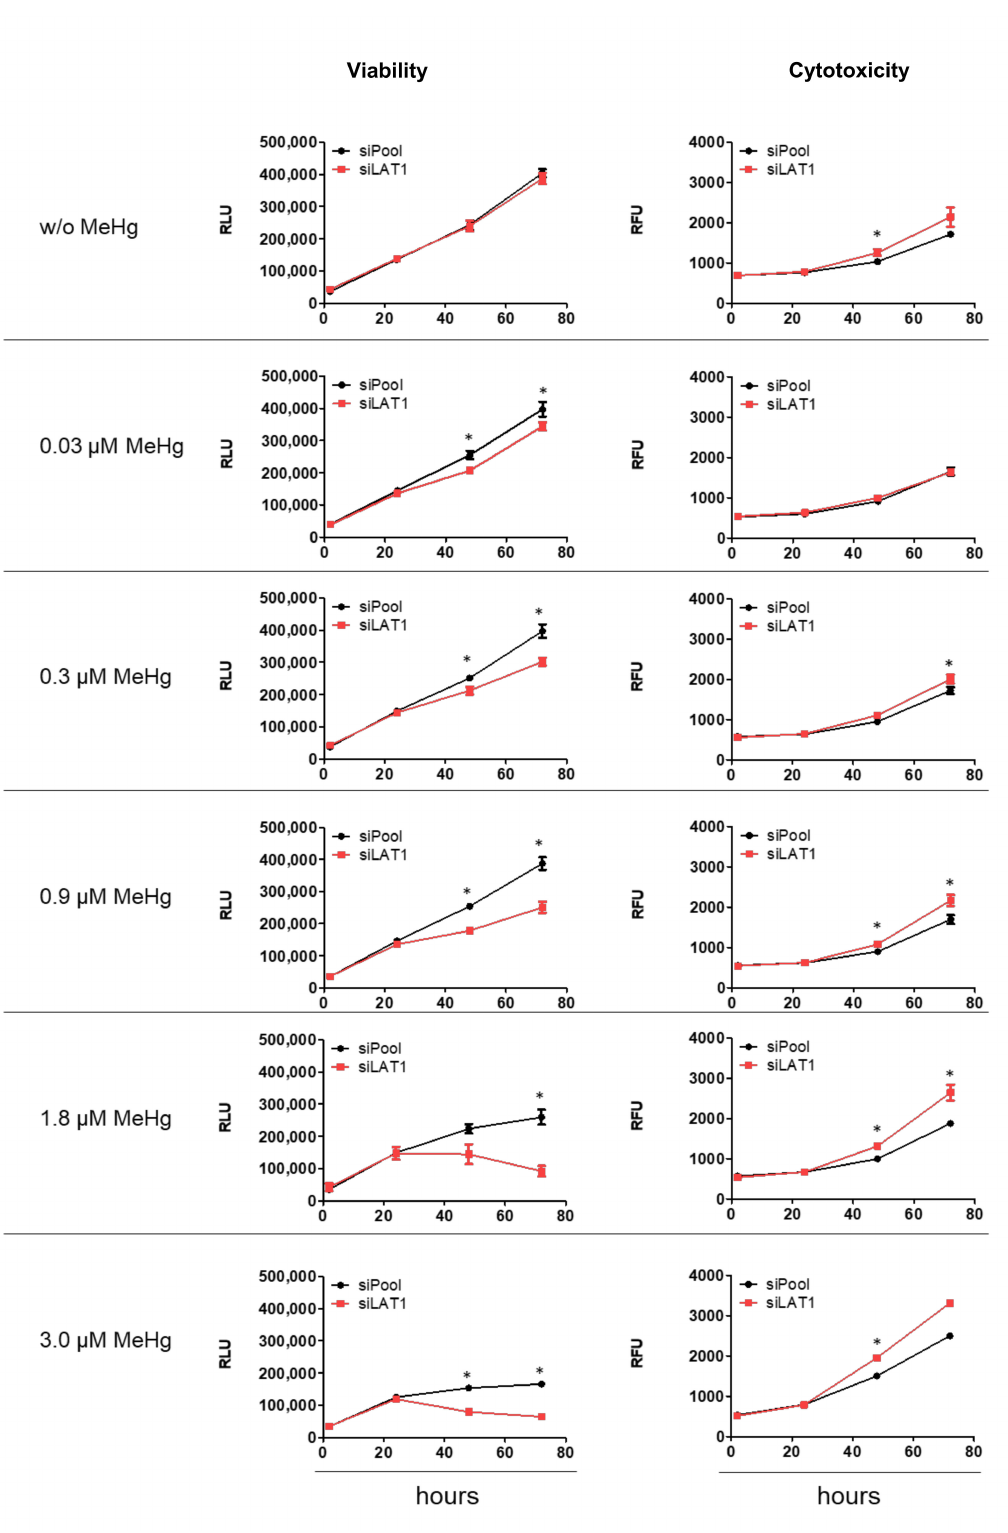
Figure 3. Cell viability and cytotoxicity in control (siPool) and LAT1-depleted (siLAT1) HTR8-SVneo cells after MeHg treatment for 72 h. RLU: Relative Luminescence Unit; RFU: Relative Fluorescence Unit. The data represent mean values ± SD from three independent experiments, each performed in triplicate. * p < 0.05 from Student’s t